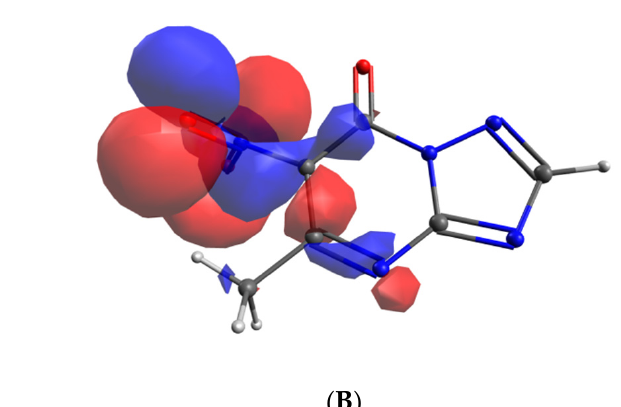
Figure 6. Orbital plot of the LUMO ( A ) of heterocyclic anion 1a and the SOMO ( B ) and its DAR (from PBE0/D3BJ/def2- TZVPP calculations).